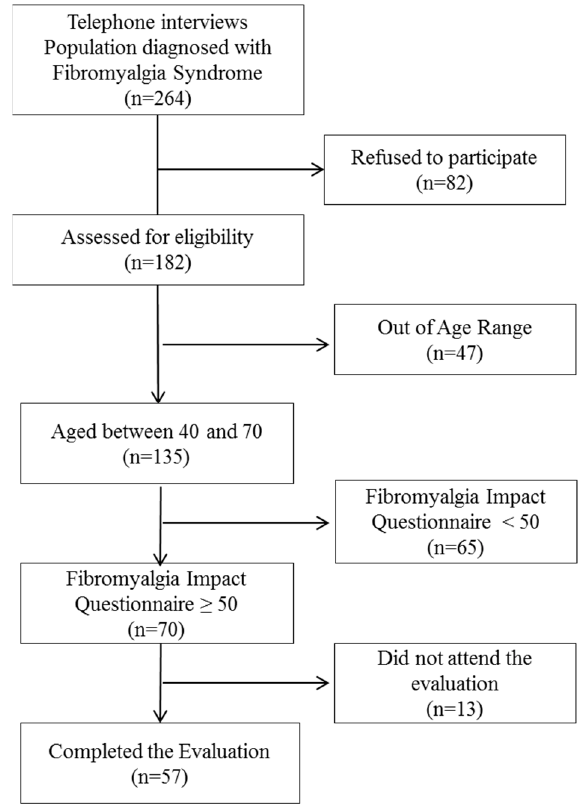
Figure 1. Flowchart showing the selection of participants. FMS: